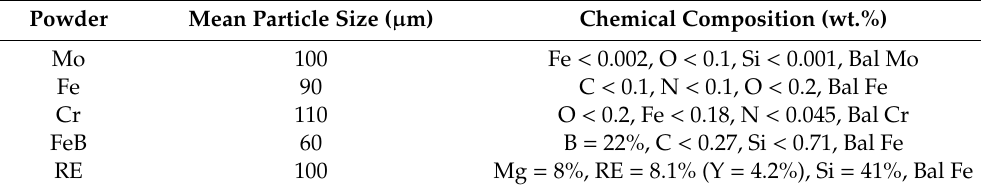
Table 1. Technical parameters of the alloy powders.